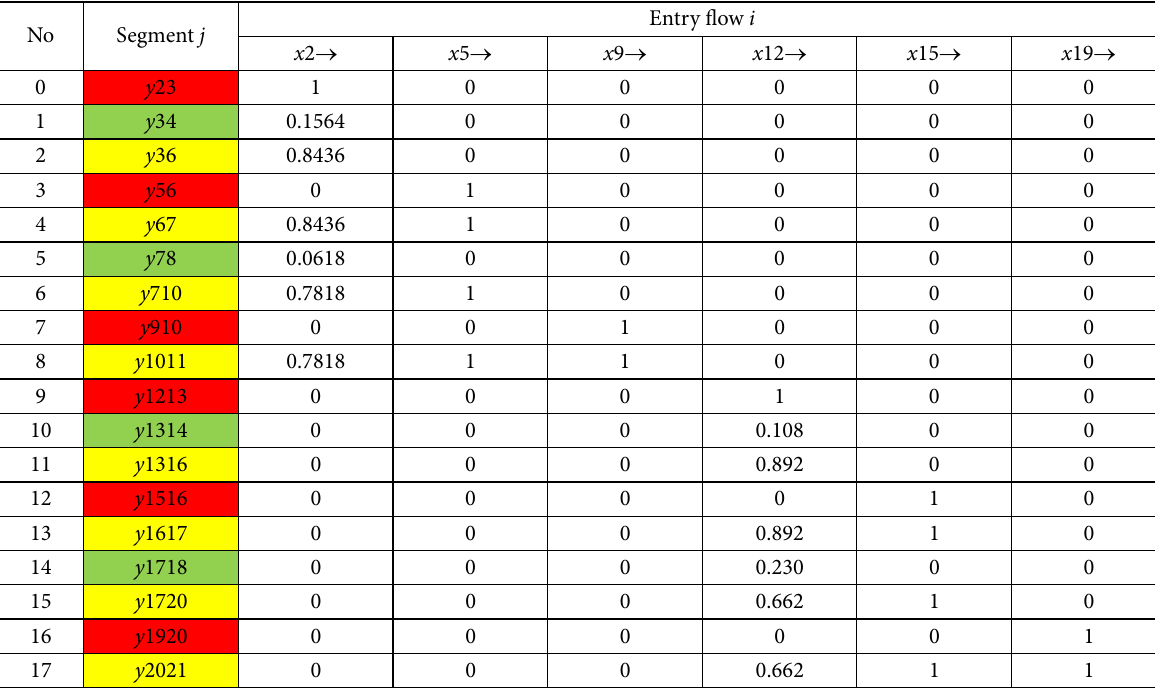
Fig. 7. The presentation of the network section as a directed graph Table 3. The incidence matrix Ab (link